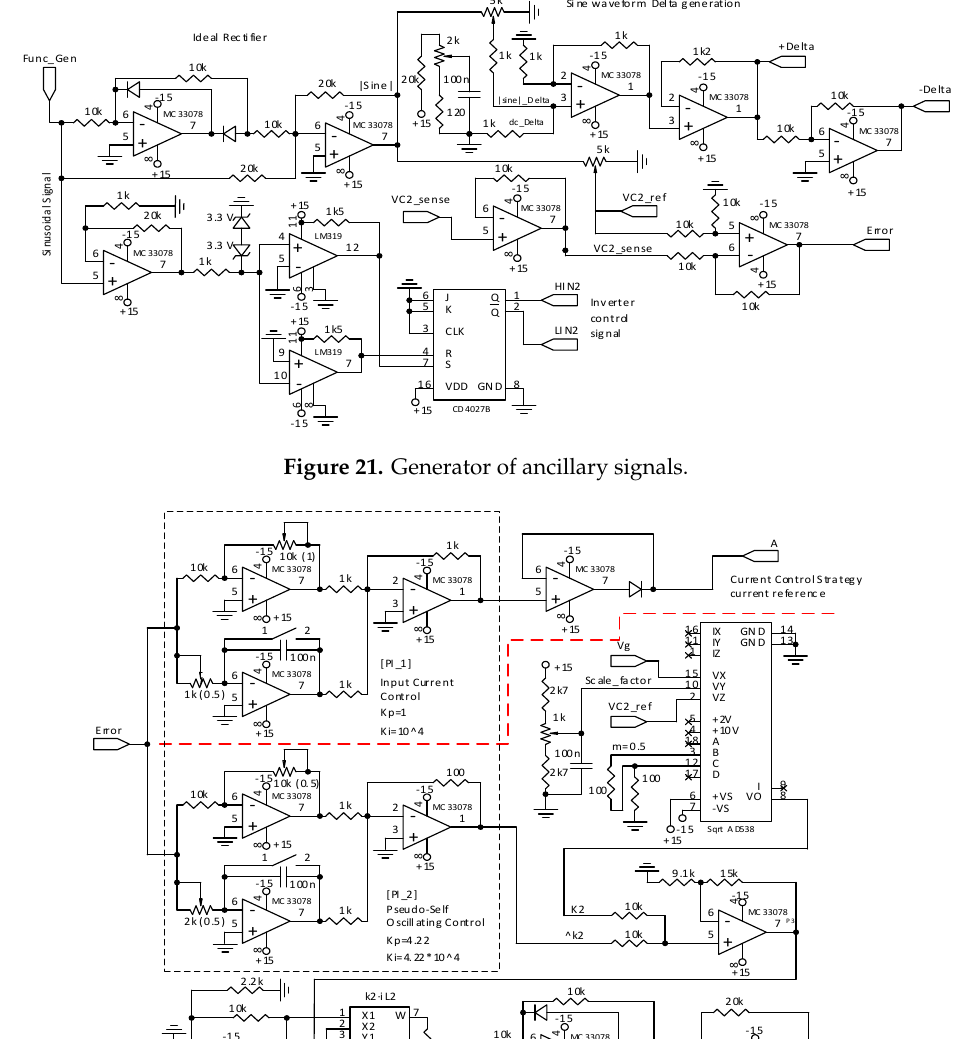
Figure 22. Control-loop and surface generator.